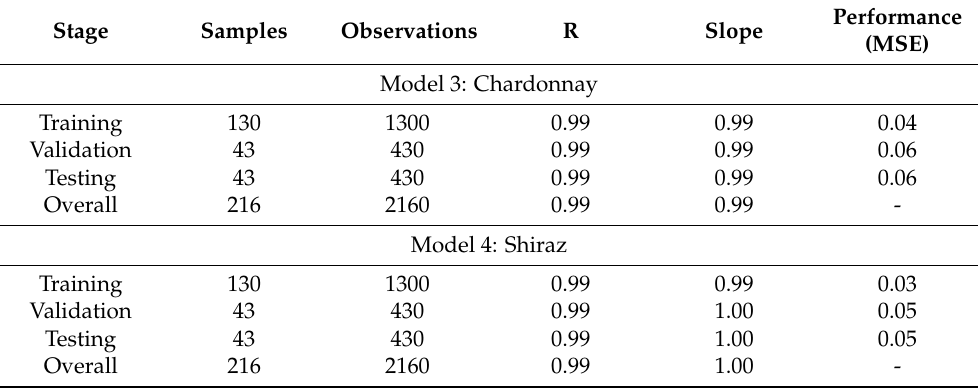
Table 4. Statistical data for each stage of the artificial neural network regression Models 3 and 4 developed using canopy architecture parameters as inputs to predict the intensity of sensory de- scriptors.